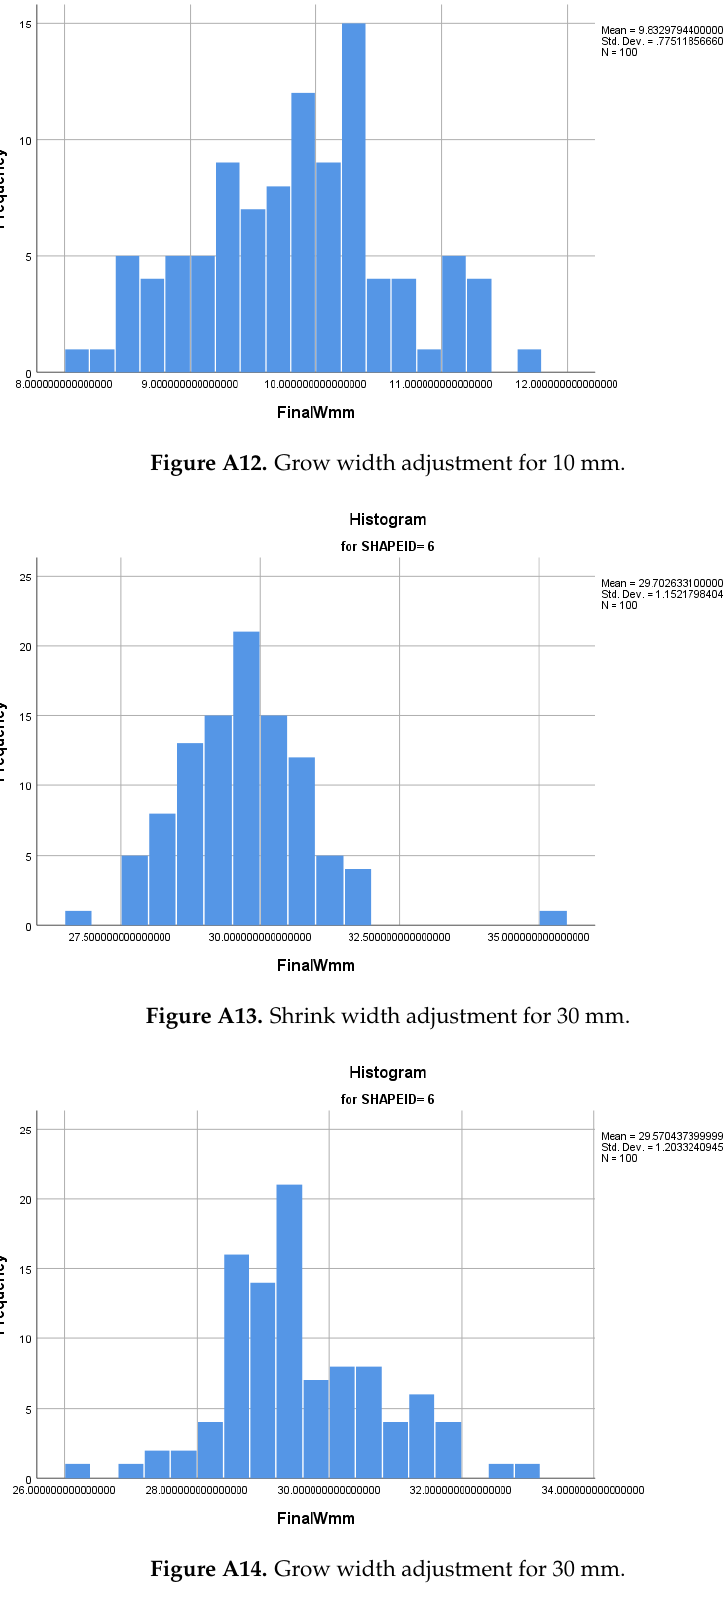
Figure A14. Grow width adjustment for 30